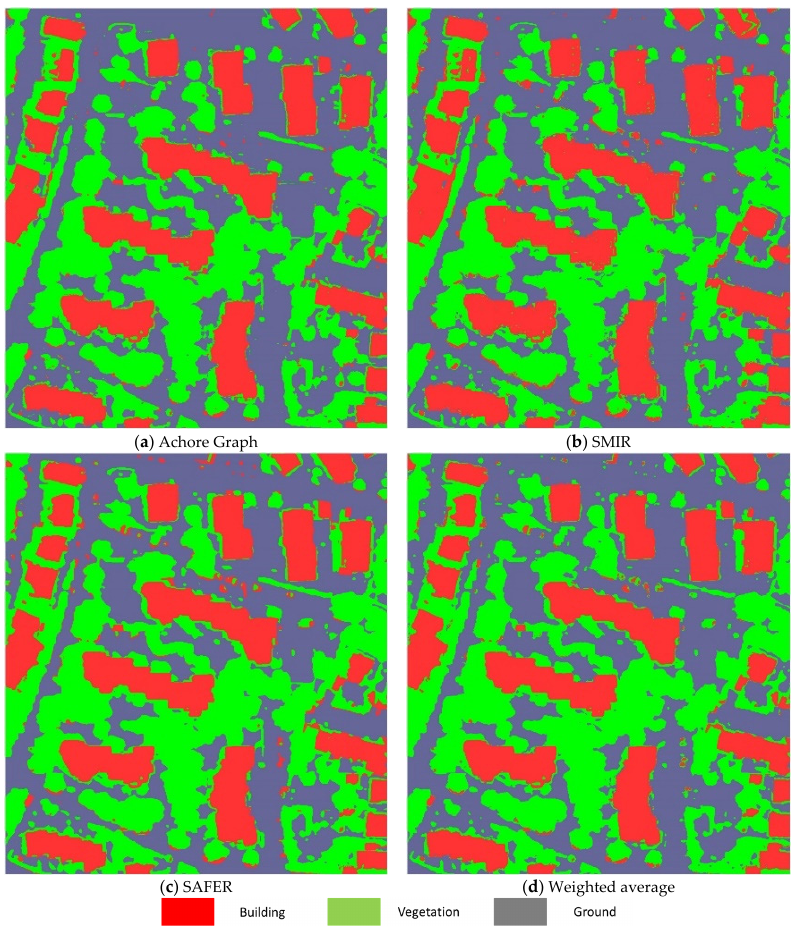
Figure 6. Illustrating the model classification outputs for the Area 2, using different SSL methods to estimate the soft labels of the unlabeled data during training. Figure 7 evaluates against the ground truth data the building detection capabilities of our model for the three examined areas. In particular, as for Figure 7a,b of Areas 1 and 2, the WeiAve SSL technique has been applied to estimate the soft labels of the unlabeled data used during the training phase. For the Area 3, the SAFER SSL is exploited. This differentiation is adopted since WeiAve best performs for Area 1 and Area 2 while SAFER is the best for Area 3. Yellow color corresponds to pixels showing a building and model classified them as building (True Positive). Red color indicates pixels that model classified as buildings, but the actual label was either vegetation or ground (False Positive). Finally, blue color indicates areas that are buildings, but model failed to recognize them (False